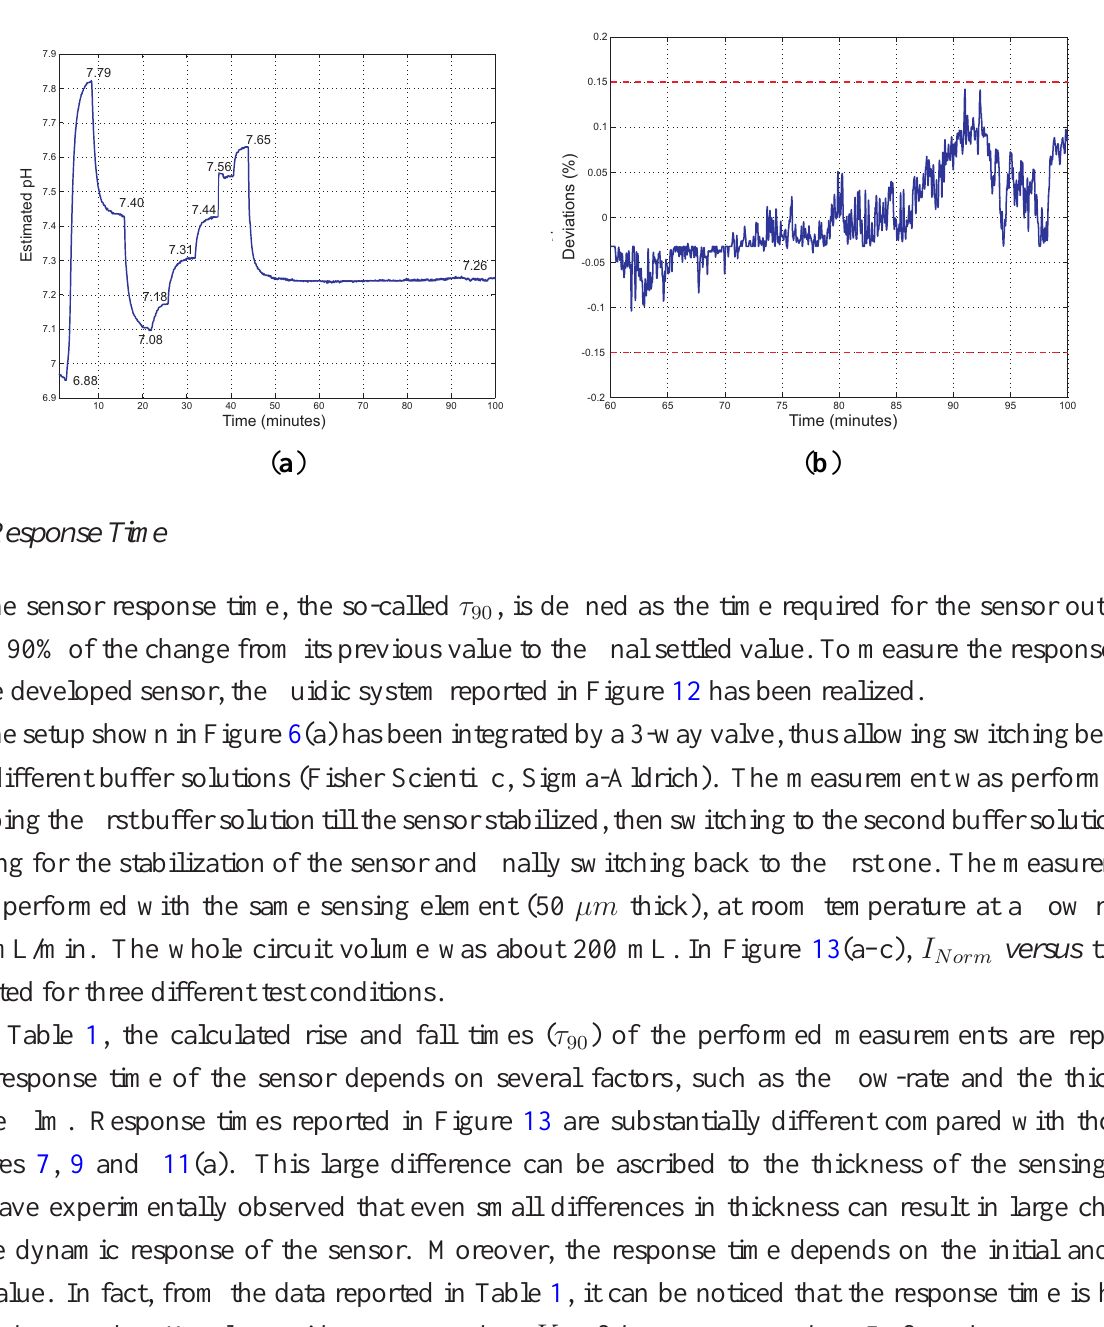
Figure 11. ( a ) Estimated pH versus time of a measurement performed changing the pH value of the solution and then keeping it constant. The steady state pH values of the solution as measured by the reference instrument are reported close to the curve. ( b ) Deviations of the estimated pH respect to its mean value in the time interval 60–100 min. All deviations are within 0.15% of the mean value of the estimated pH (dashed